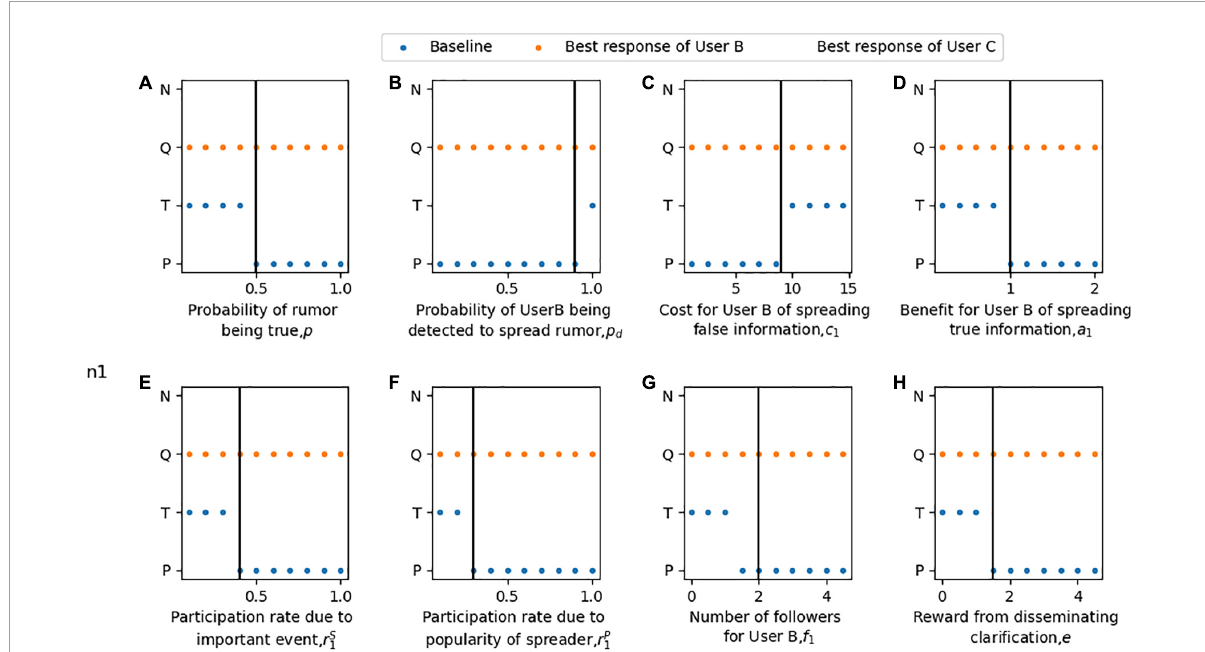
FIGURE2 The best response of User B and User C gave that User A clarified the rumor in the rumor clarification model. For part panel (A–H) , the x-axis represents the change of each parameter, the y-axis indicates the optimal choice of Users B and C with the change of parameters when given that User A chooses to clarify rumors. Blue indicates the strategy P or T of User B. Orange indicates the strategy Q or N of user C. The vertical bar indicates the baseline value of each parameter.